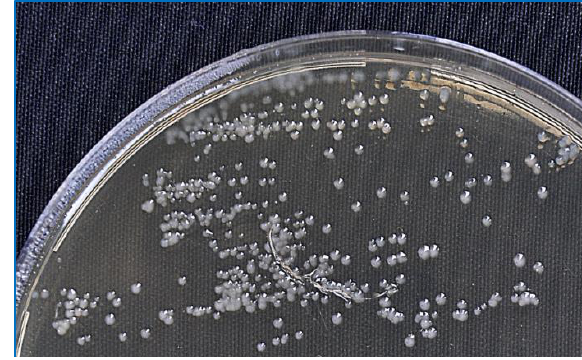
Figure, 1: Colony of Brucella abortus on Brucella agar showing the pearly white